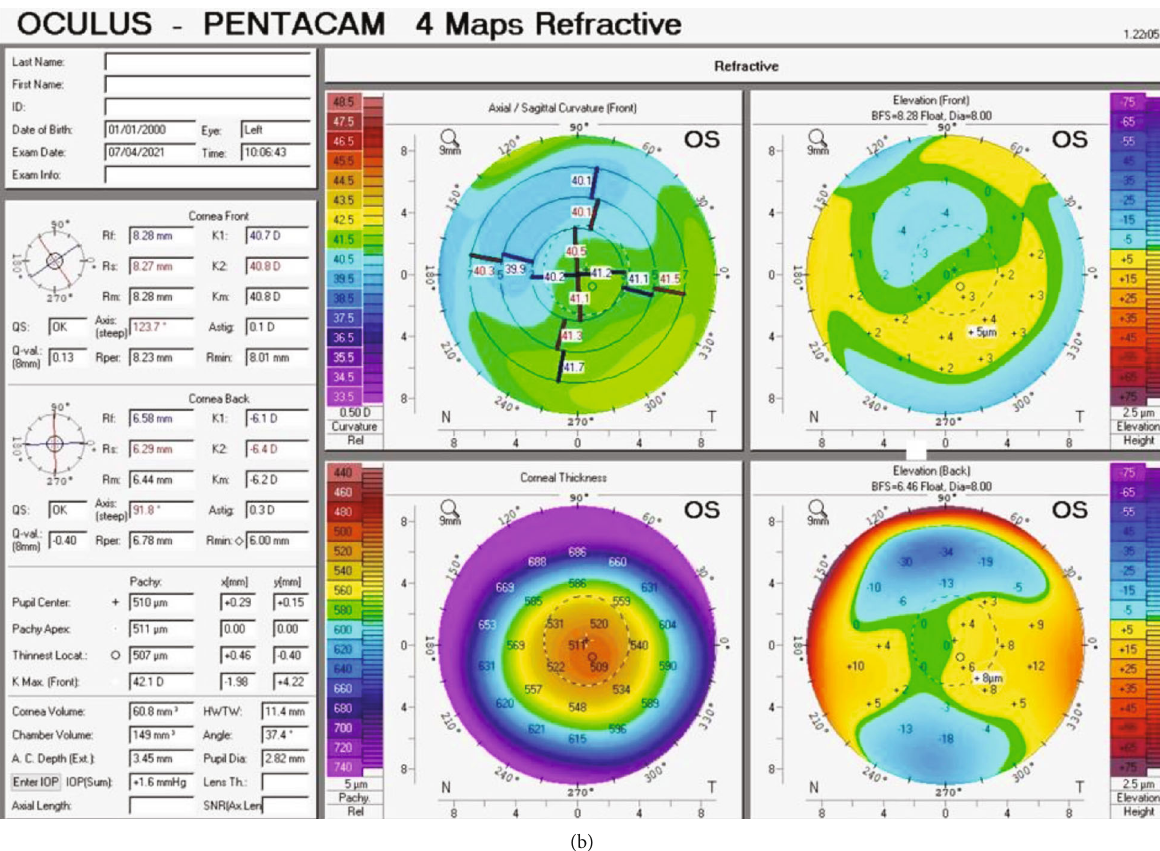
Figure 3: Postoperative corneal topography printouts of the right (a) and the left (b) eyes show no sign of corneal ectasia (Oculus-